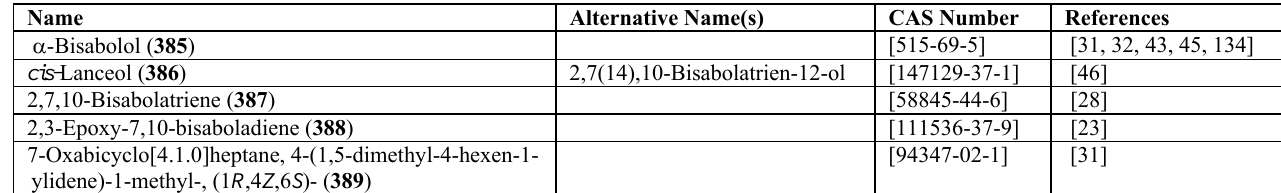
Table 30. Bisabolanes Sesquiterpenoids (1-(1,5-Dimethylhexyl)-4-methylcyclohexane,